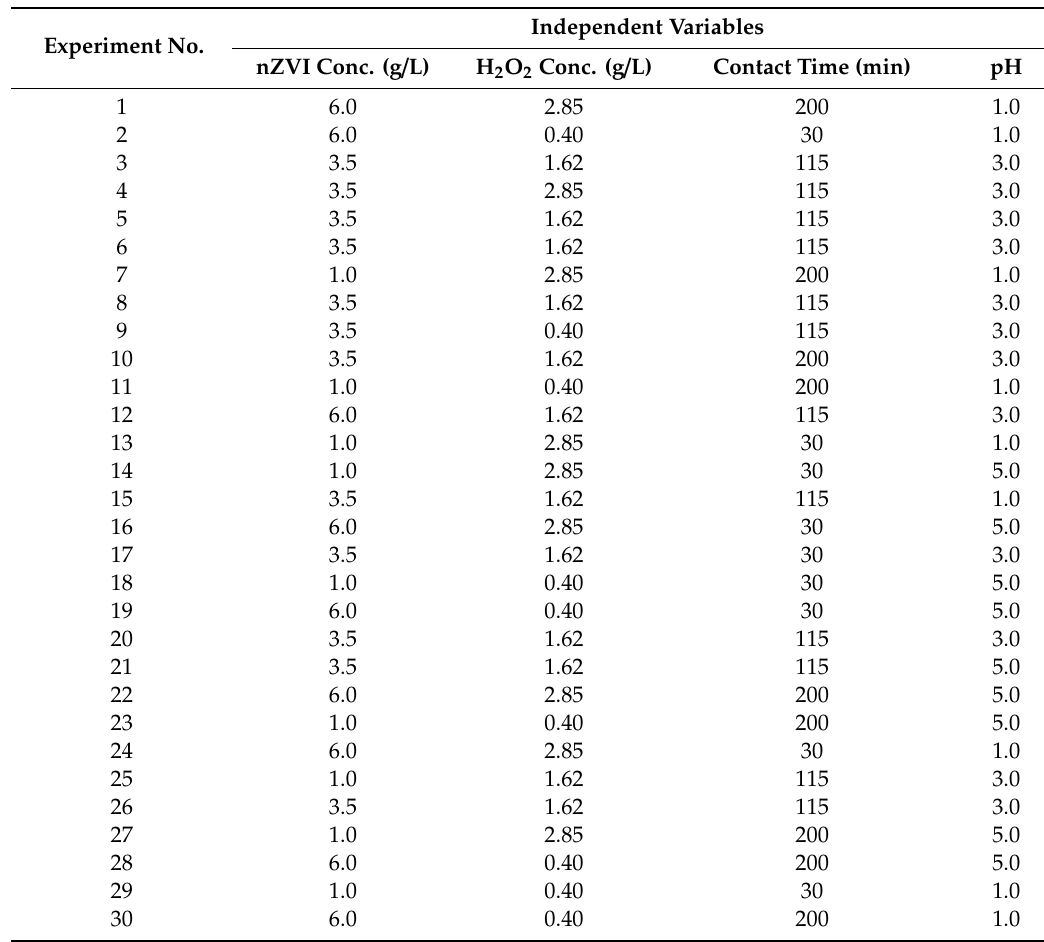
Table 2. Experimental runs for PAHs and chemical oxygen demand (COD) removal. Experiment No.